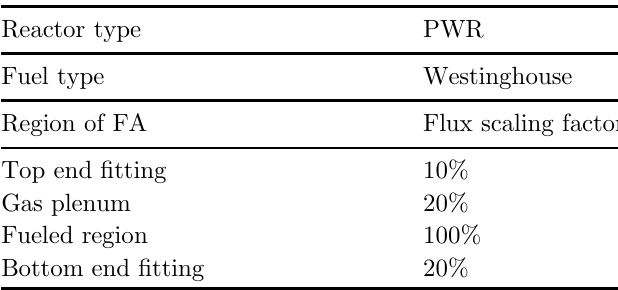
Table 3. Neutron fl ux regions in FA